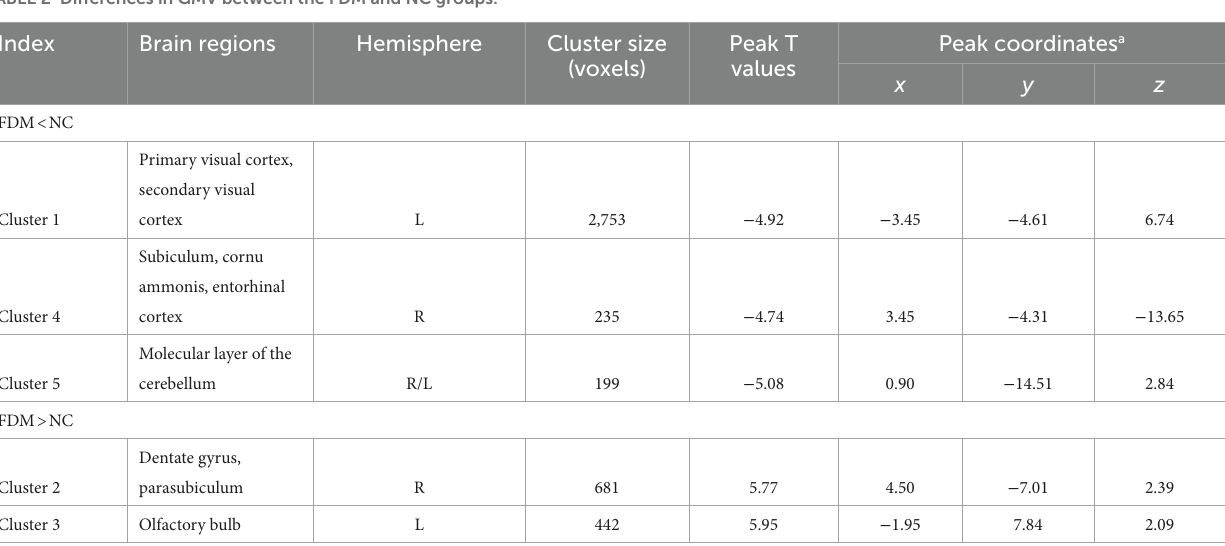
TABLE 2 Differences in GMV between the FDM and NC